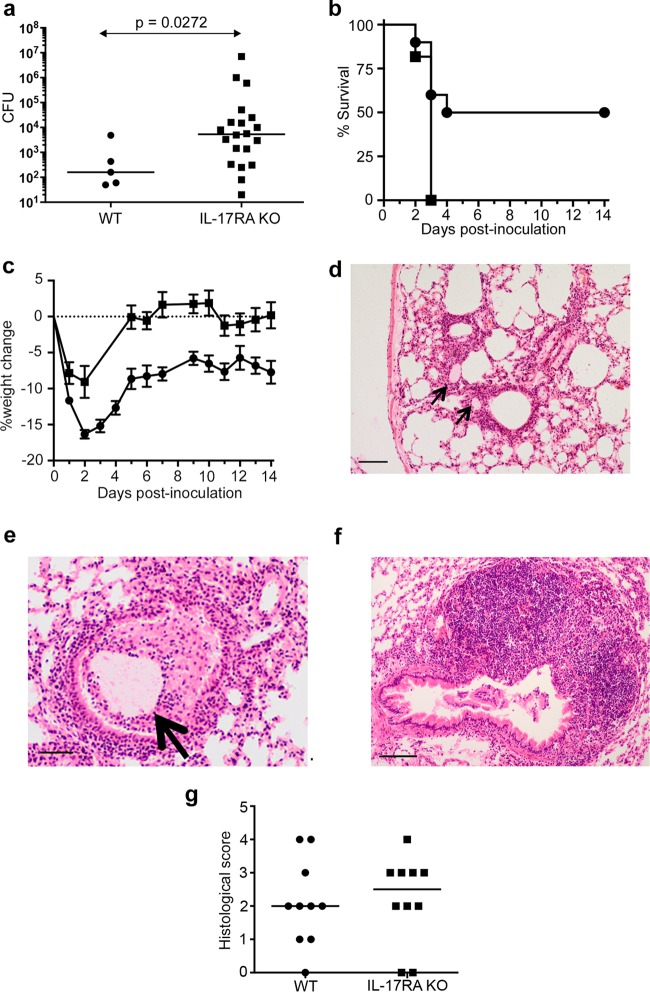
Responses of WT and IL-17RA-knockout animals to pulmonary P. aeruginosa infection. (a) Pulmonary bacterial burdens in animals chronically infected with YH5 at 2 weeks postinfection. Lines indicate median values. P value was determined with the Mann-Whitney test from pooled results of two experiments, each with 10 mice per group. (b) Kaplan-Meir survival curves of WT (circles) or IL-17RA knockout (KO) animals (squares) infected with the NH57388A strain (n = 10 per group). Significant differences were determined by log rank test; P = 0.0092. (c) Weight changes in animals (n = 10) remaining chronically infected at 14 days following infection with the YH5 strain; results are for WT (circles) or IL-17RA KO animals (squares). Each point represents the mean weight at that time; error bars show SEM. Differences between the groups are significant at a P value of <0.0001 by repeated-measures ANOVA. (d, e) Hematoxylin and eosin (H&E)-stained lung sections from infected WT mice 2 weeks after infection with YH5 strain. Arrows show agar beads. Scale bars show 100 μm (d) or 50 μm (e). (f) Large (>50 cells deep) monocytic accumulations were observed in lungs from IL-17RA KO mice. Scale bar shows 10 μm. (g) Histological scores for indicated animals 2 weeks after infection with YH5 strain. P = 0.7266 by Mann-Whitney test.